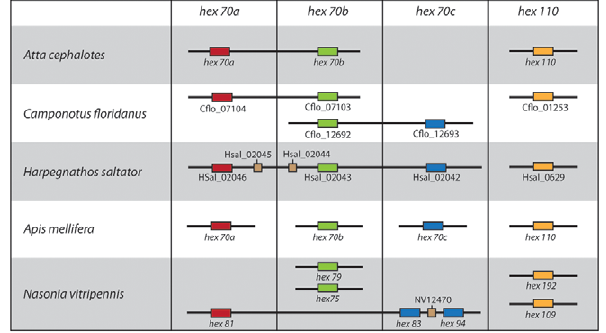
Figure 4. Distribution of hexamerin genes in the genomes of Atta cephalotes , Camponotus floridanus , Harpegnathos saltator , Apismellifera , and Nasoniavitripennis . Four hexamerins with varying copy number are found within these genomes except for A. cephalotes which is missing hex 70c . Many of these genes are found to be syntenic along chromosomes/scaffolds, as shown (not drawn to scale).